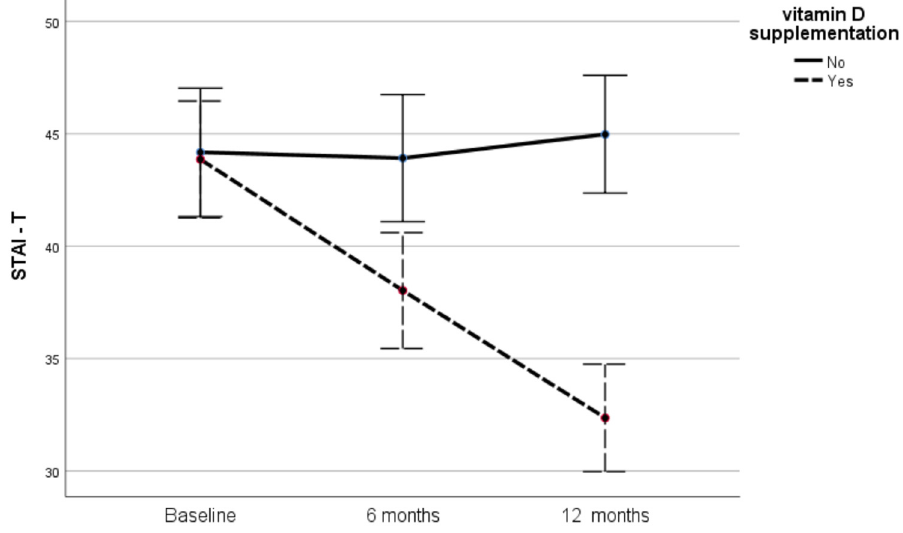
Figure 1. Changes in STAI-T scores in the two groups during the study. At baseline, the mean value of the STAI-S score for controls and supplemented indi- viduals was 42.94 ± 9.14 and 42.66 ± 8.43, respectively, and the difference between the two groups was not significant ( p = 0.89). After 6 and 12 months, the STAI-S values for the supplemented participants decreased significantly to 37.11 ± 7.88 ( p < 0.001 compared to baseline) and 32.59 ± 6.45 ( p < 0.001 compared to baseline and 6 months), respectively. The respective values for the control group were 43.20 ± 9.33 and 44.60 ± 9.53, with the increase from 6 to 12 months being marginally significant ( p = 0.043). Table 3 and Figure 2 present the evolution of STAI-S values in the two groups throughout the study. As shown in Table 3, at both 6 and 12 months, the supplemented participants presented significantly lower values of the STAI-S score compared to the controls ( p = 0.003 and <0.001, respectively). Table 3. Evolution of STAI-S scores and differences between the two groups throughout the study period.